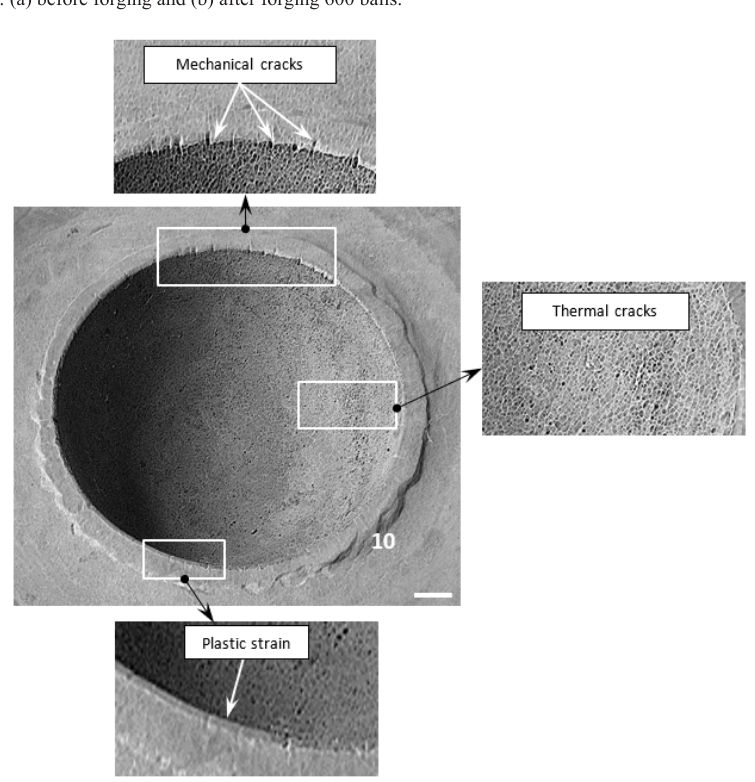
Figure 8. Top view of the cavity of lower die after 600 forging